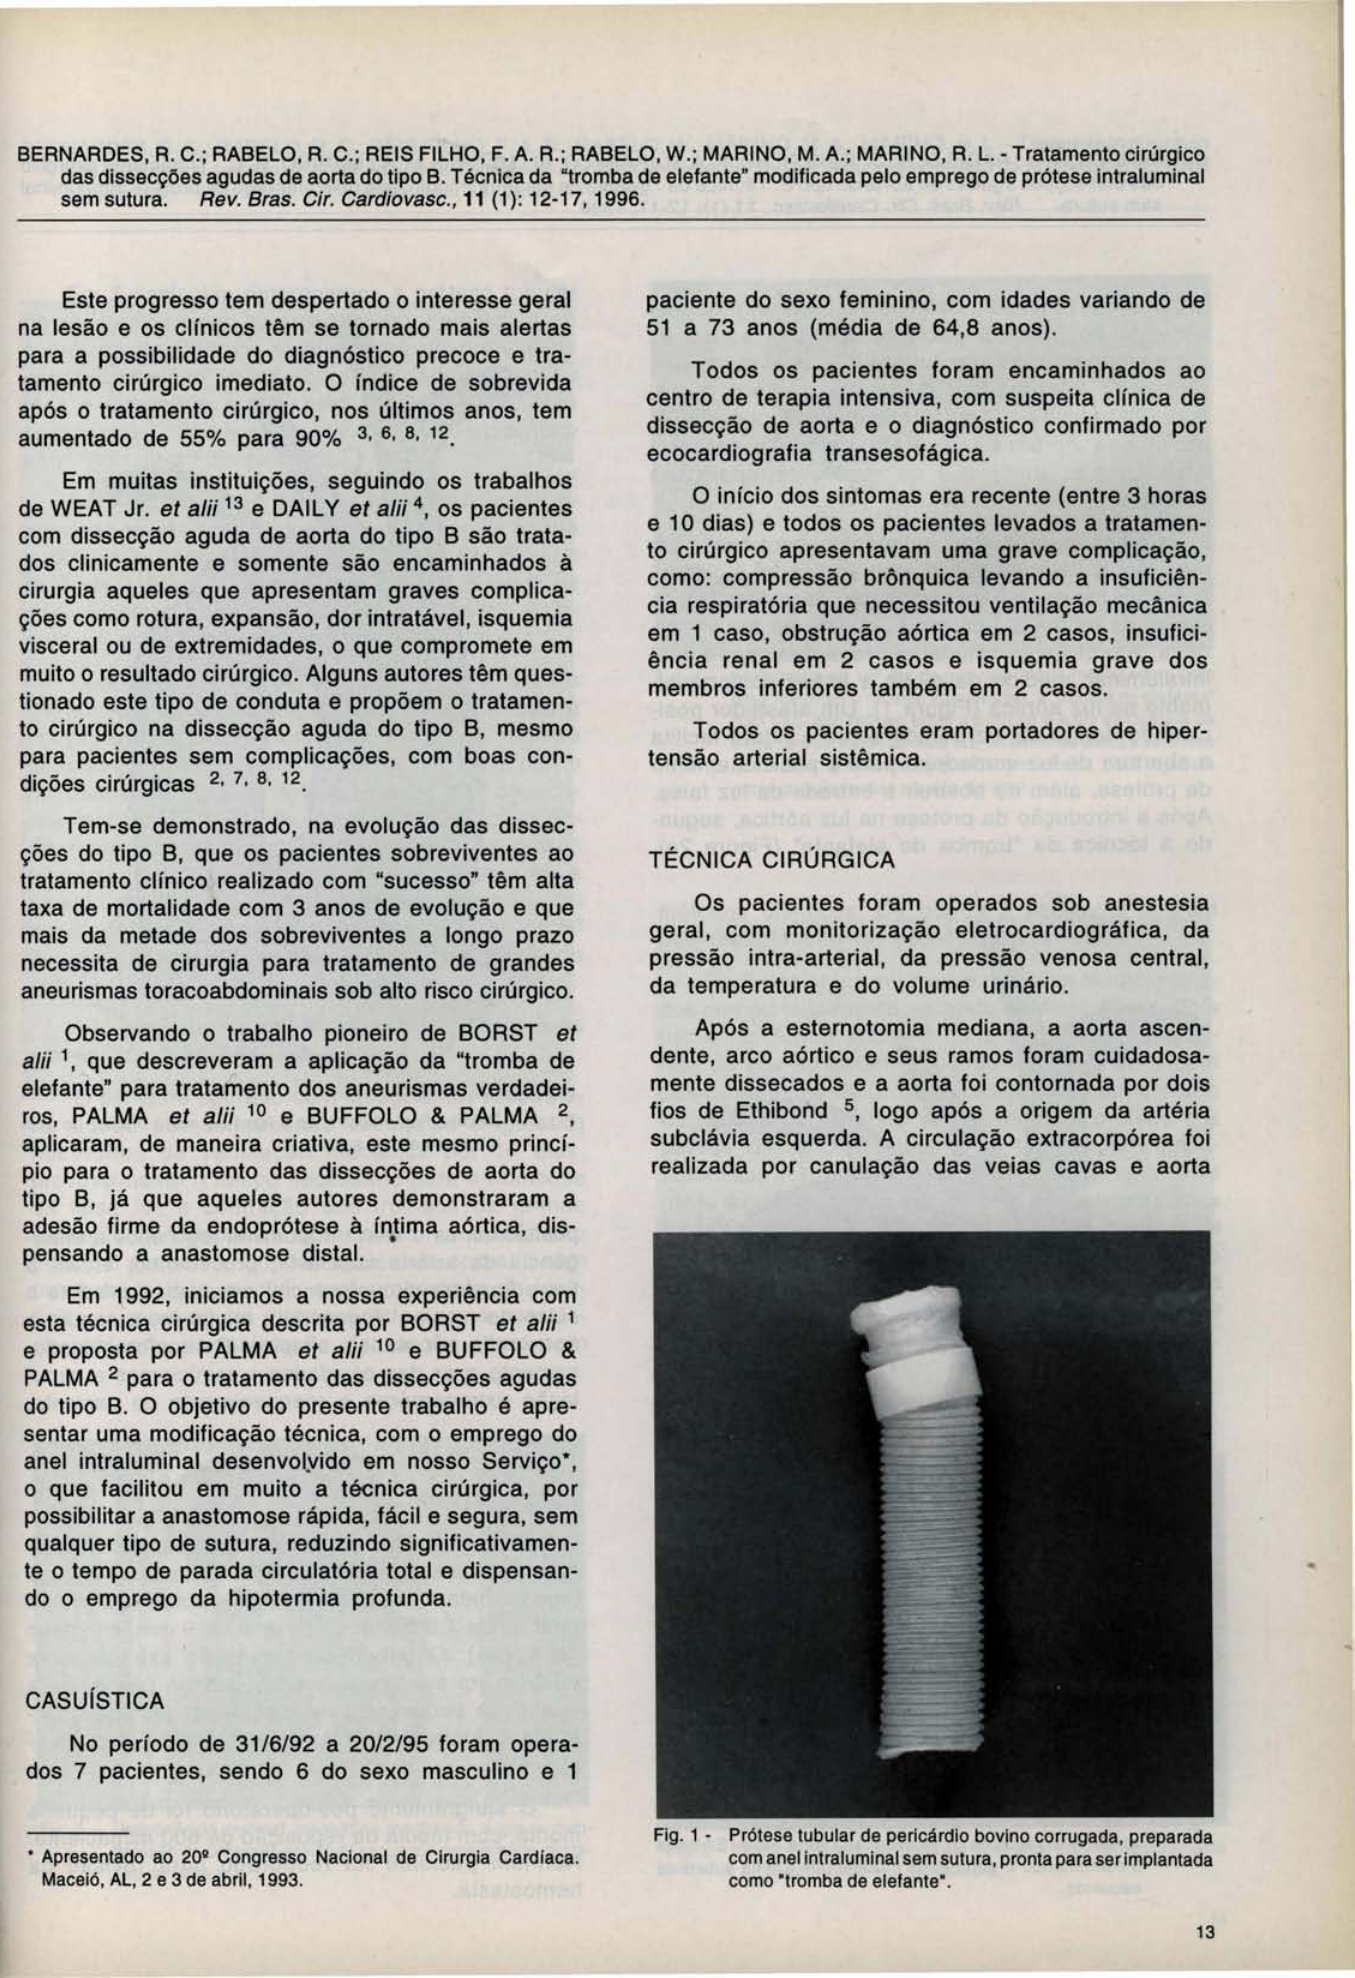
Fig. 1 - Prótese tubular de pericárdio bovino corrugada, preparada com anel intraluminal sem sutura, pronta para ser implantada como 'tromba de